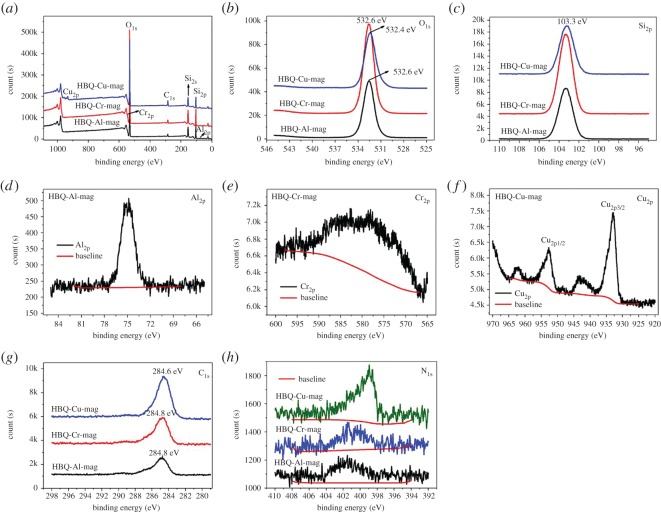
XPS spectra of HBQ-M-mags (M = Al, Cr and Cu): (a) full spectra; (b) core-level spectra of O1s; (c) core-level spectra of Si2p; (d) core-level spectrum of Al2p; (e) core-level spectrum of Cr2p; (f) core-level spectrum of Cu2p; (g) core-level spectra of C1s; (h) core-level spectra of N1s.